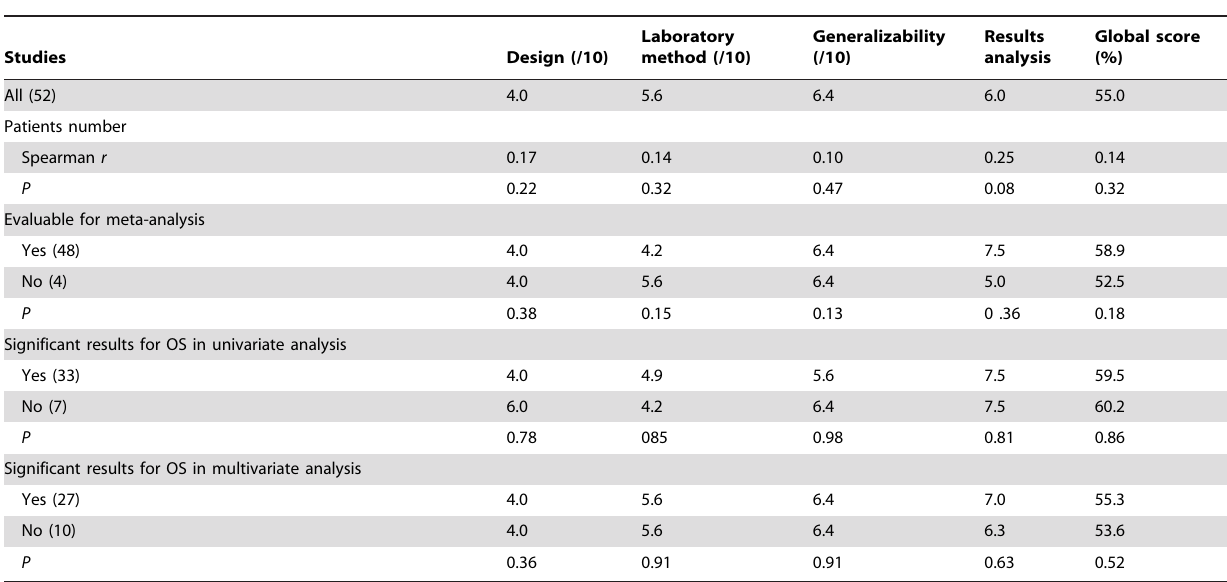
Table 1. Quality scores analysis of the 52 eligible studies by the European Lung Cancer Working Party score according to studies